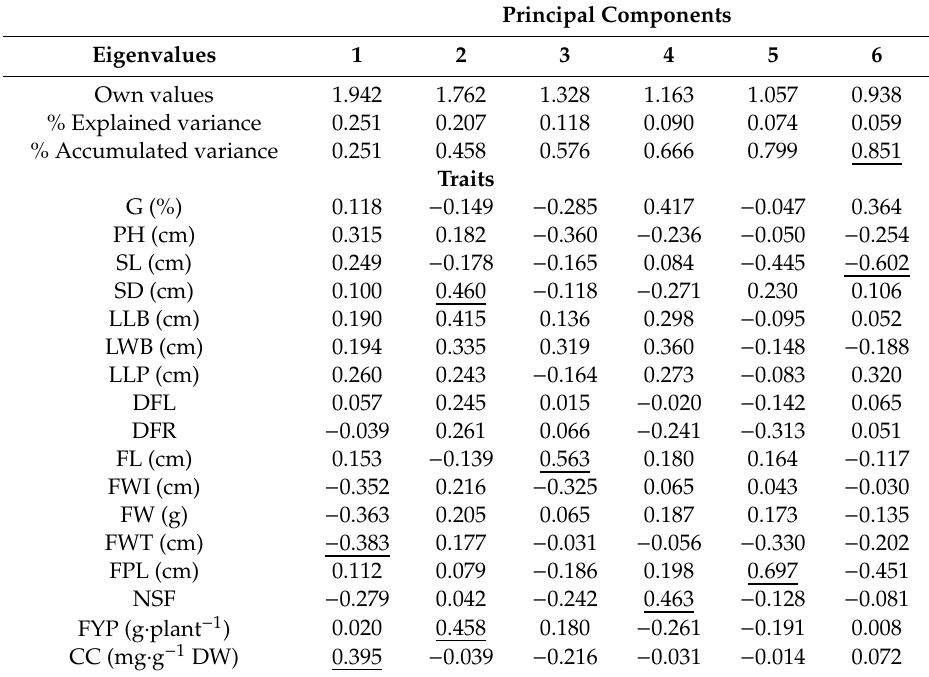
Table 7. Principal components, own values, self-values, and percentage of explained total variance.